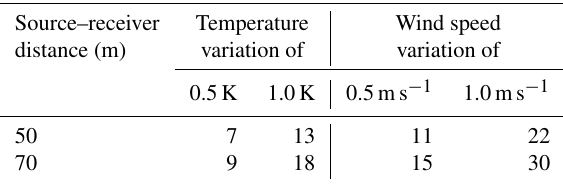
Table 2. Variability in acoustic travel time (in rounded sample units) due to changes in temperature and wind speed for a mean tempera- ture of about 8 ◦ C.